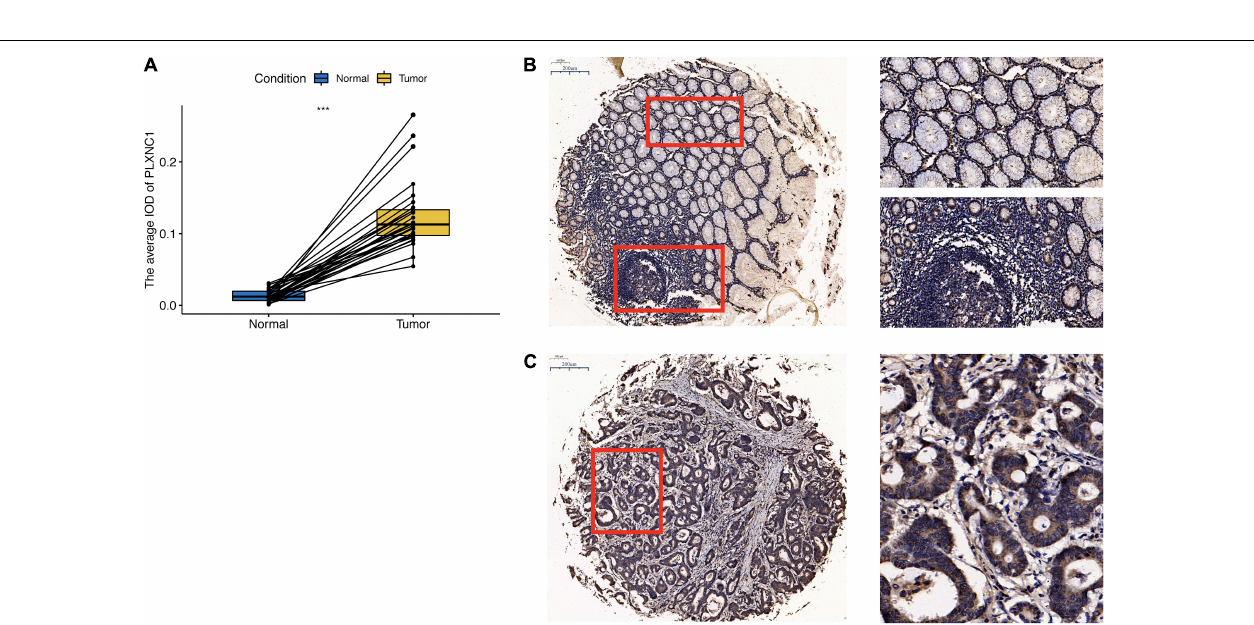
FIGURE 6 | (A) PLXNC1 protein expression was significantly upregulated in STAD samples ( N = 28, paired t -test, p < 0.001). (B) Left image: Immunohistochemical staining examined at × 100 magnification. Red boxes are zoomed in regions corresponding to images on the right. Right images: Low PLXNC1 expression was observed in normal tissues and mainly nuclear staining in a collection of immune cells. The work distance is 0.55, objective lens is 20X Zeiss PlAN-Apo and N.A. is 0.8. (C) Immunohistochemical staining of PLXNC1 protein in STAD tissues examined at × 100 magnification. PLXNC1 expression was observed mainly in cytoplasm or membrane staining in tumor cells. The work distance is 0.55, objective lens is 20X Zeiss PlAN-Apo and N.A. is 0.8.